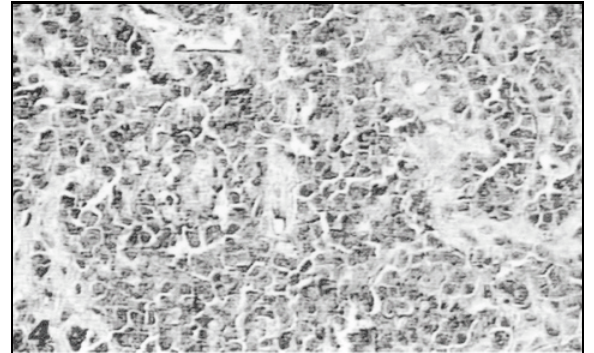
Figure 8 – Mastocytoma, anti-proliferation marker Ki-67, nuclear staining (x 1.000)